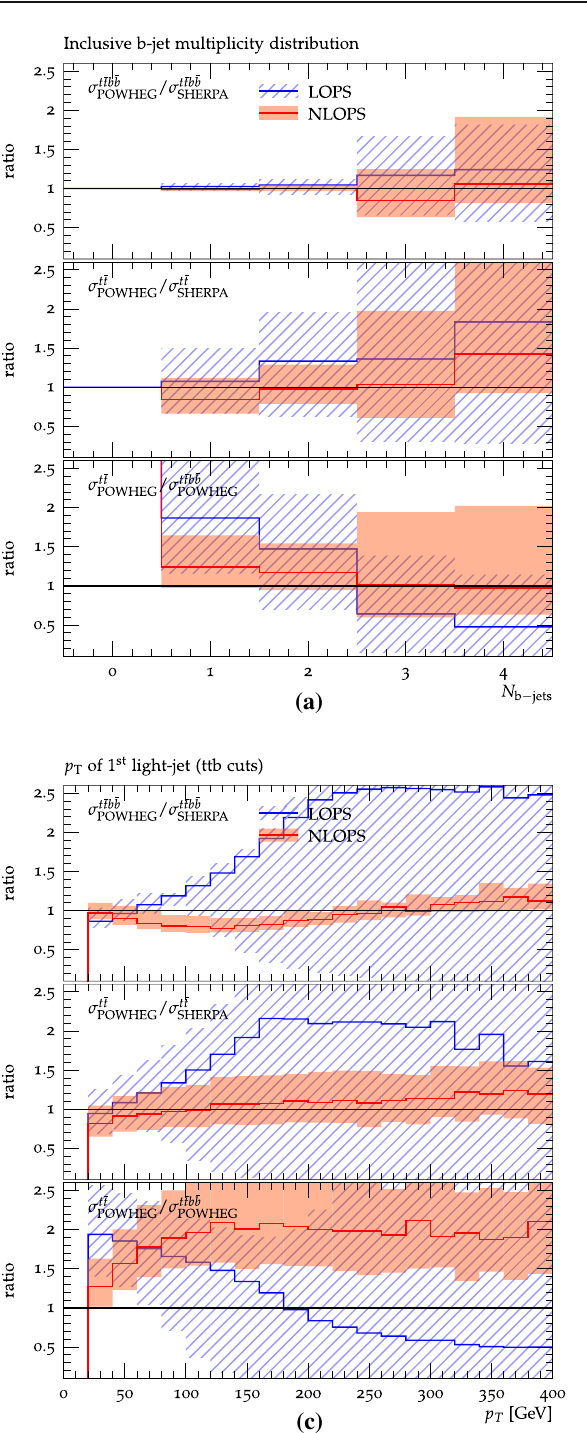
√ Fig. 11 Predictions for pp → t ¯ t + b -jets at s =13TeV: distributions and pp → t ¯ t simulations, respectively. The third frame displays the ratio of t ¯ t to t ¯ tb ¯ b Powheg predictions. For all ratios the numerator in the inclusive number of additional b -jets ( a ), the p T of the first b -jet and denominator are evaluated at the same order, and uncertainties are ( b ) and the first light jet ( c ) with ttb cuts, and in the p T of the sec- applied only to the numerator. They correspond to the combination in ond b -jet with ttbb cuts ( d ). The various ratio plots compare t ¯ t + b -jet quadrature of h damp and h bzd variations with the uncertainties due to observables as described in LOPS (blue) and NLOPS (red) simulations based on pp → t ¯ tb ¯ b or pp → t ¯ t matrix elements in Powheg+Pythia the modelling of g → b ¯ b splittings and the choice of α S and scalup or Sherpa . In the ratios shown in the upper and middle frame Powheg in Pythia (see Sects. 3.2–3.3). Top quarks are kept stable predictions are normalised to Sherpa ones for the case of pp → t ¯ tb ¯ b